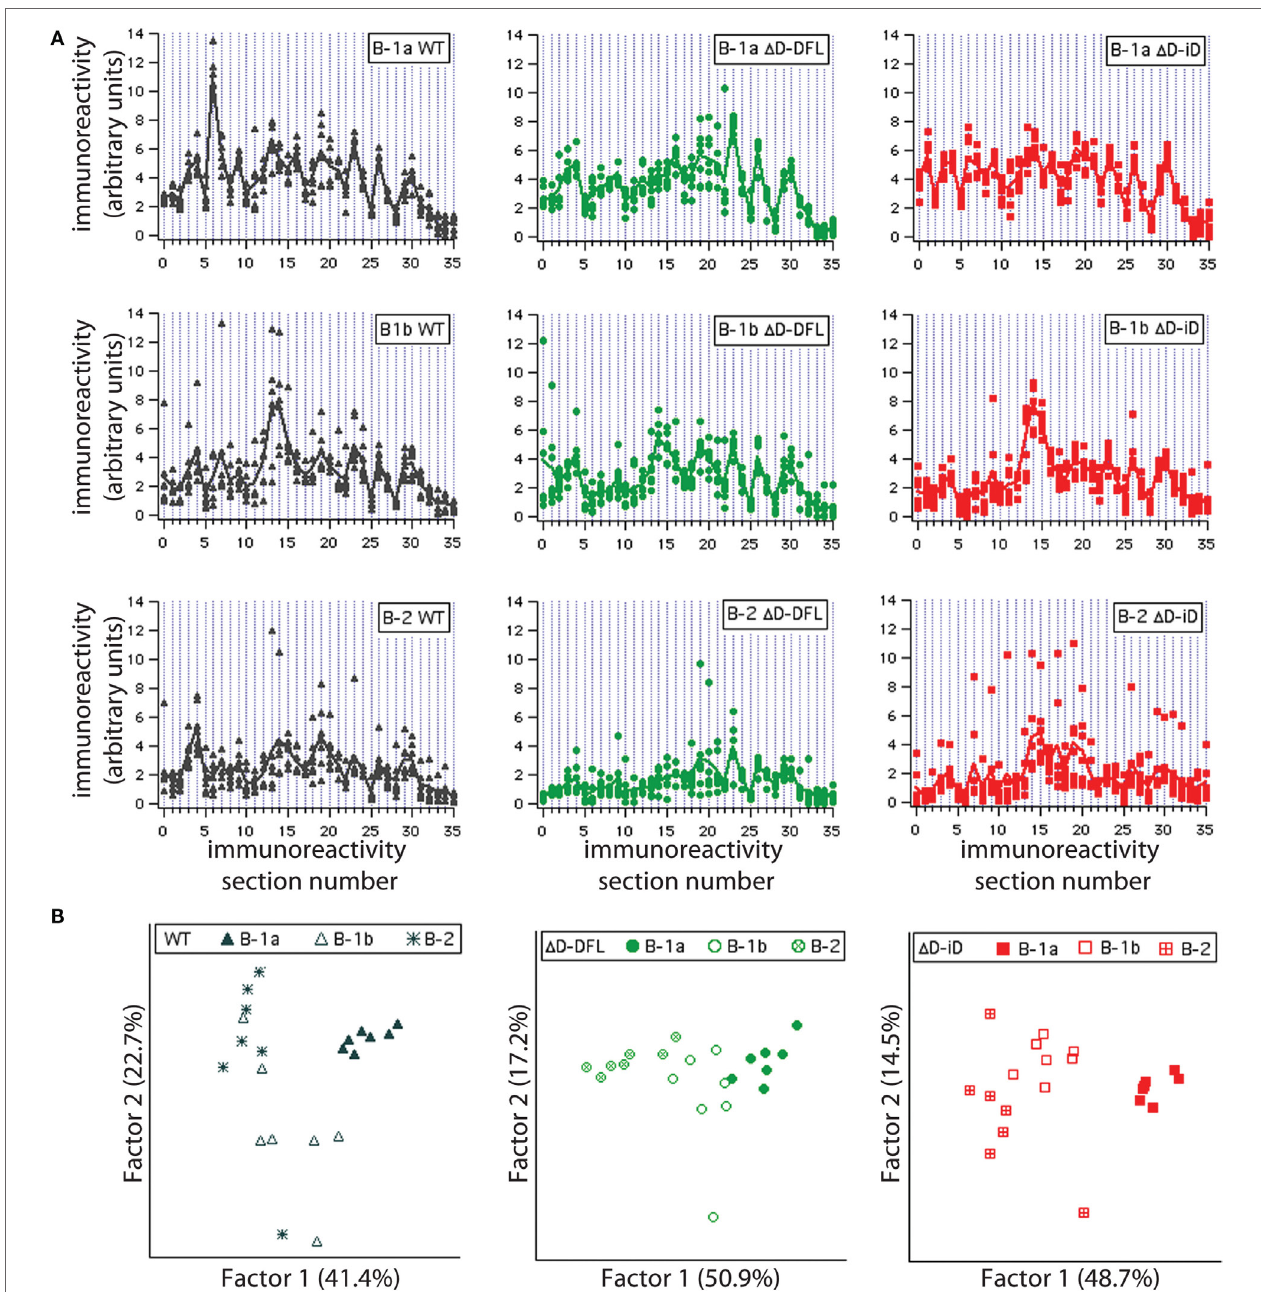
FigUre 5 | graphic representation of variance distribution of each B cell subset reactivity profile within each mouse strain . (a) Profiles of reactivities and distribution around the mean profile of each PerC B cell subset from WT, Δ D-DFL, and Δ D-iD are represented graphically. (B) Principal component analysis (PCA) of reactivity profiles from each mouse strain discriminates B cell